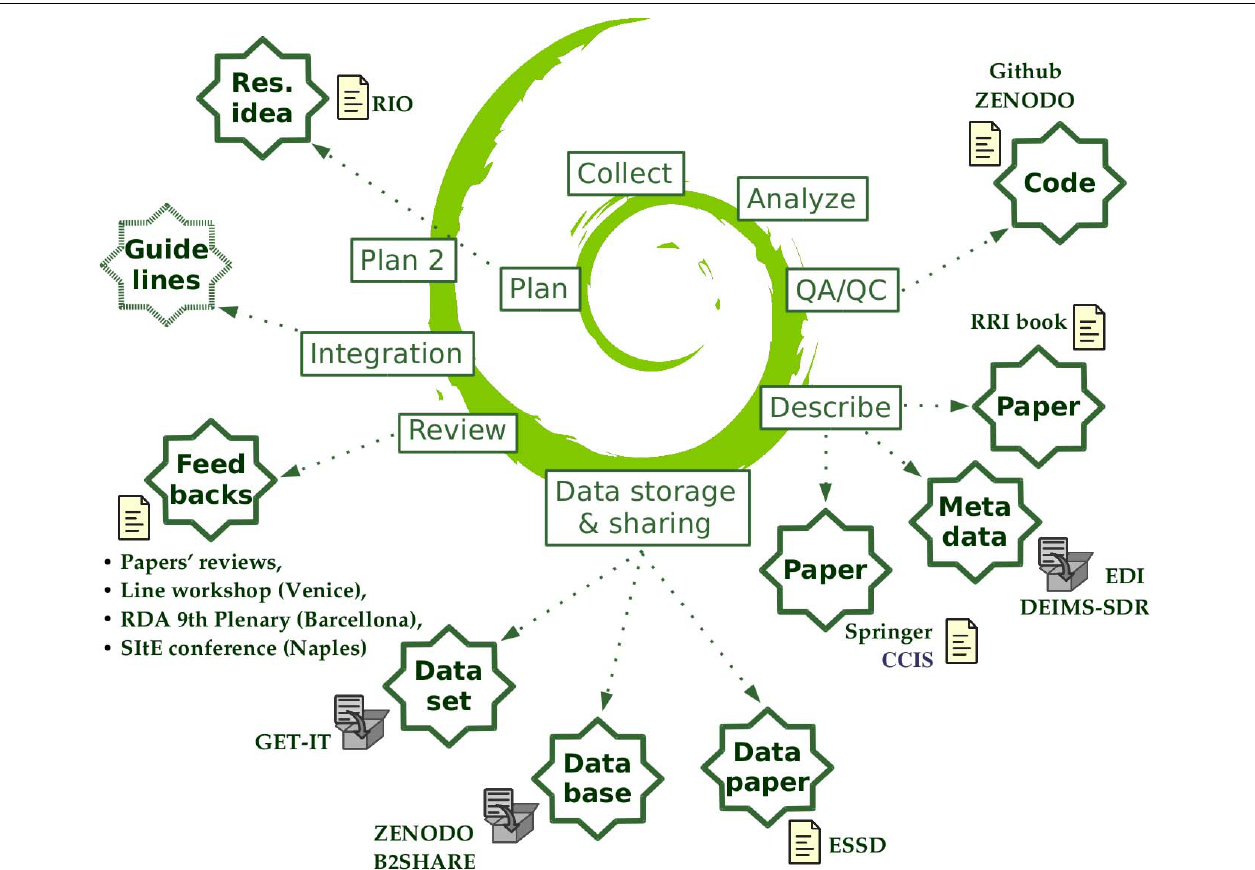
FIGURE 1 | The open research project lifecycle applied to EcoNAOS: each callout represents a sharing action related to the relevant project steps, e.g., for the data storage and sharing phase, we stored data into an open repository, we wrote a data paper published in open access and we finally shared data through an open source software (GET-IT), compliant with OGC specifications, for visualizing data